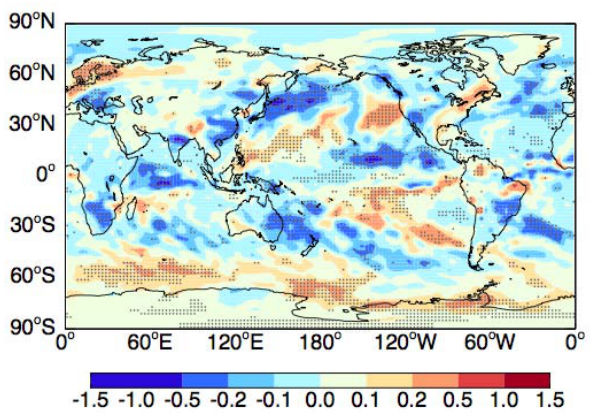
Fig. 4. Changes in annual mean stratiform (large-scale) precipita- tion (unit: mmday − 1 ) driven by climate change (derived as “2000” – “1860CL2000emis” simulations). Dotted areas indicate changes significant at the 95% confidence level as assessed by student